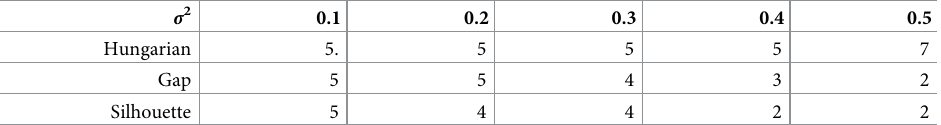
Table 1. The average number of clusters by after adding noise to the five centres with various σ